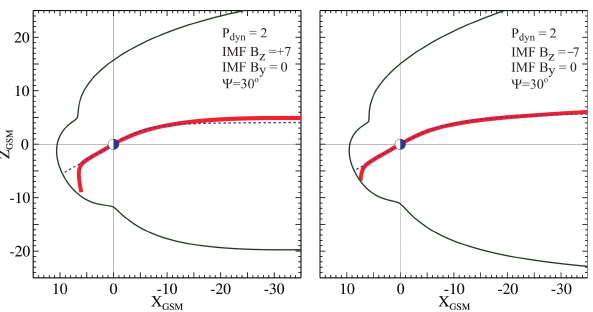
Figure 9. Illustrating the effect of the IMF B z on the shape of the current sheet in the distant tail cross section at X GSW = − 30 R E . In both cases P dyn = 2nPa.